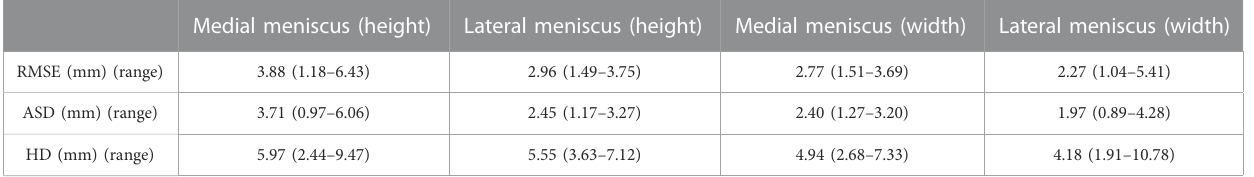
TABLE 10 Median RMSE, ASD and HD with range between predicted and measured height and width of the medial meniscus (MM) and lateral meniscus (LM). Medial meniscus